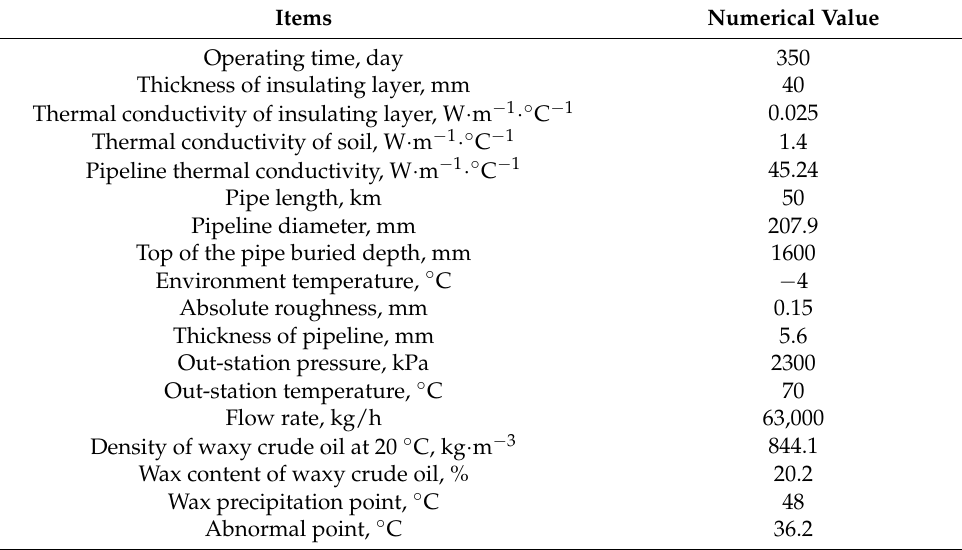
Table 1. Pipeline operating parameters and physical parameters of the crude oil. Items